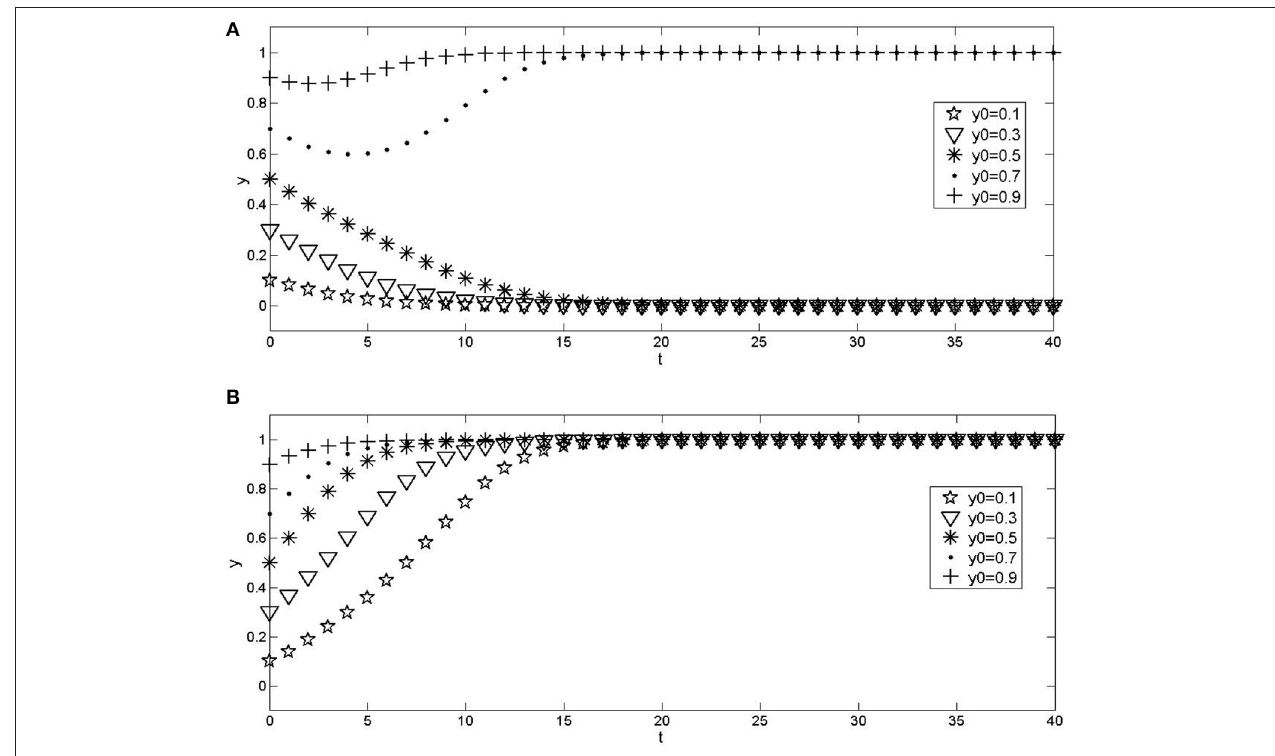
FIGURE 2 | Effects of different initial proportions of institutions that choose a strategy on evolution results. (A) x = 0.2; (B) x =